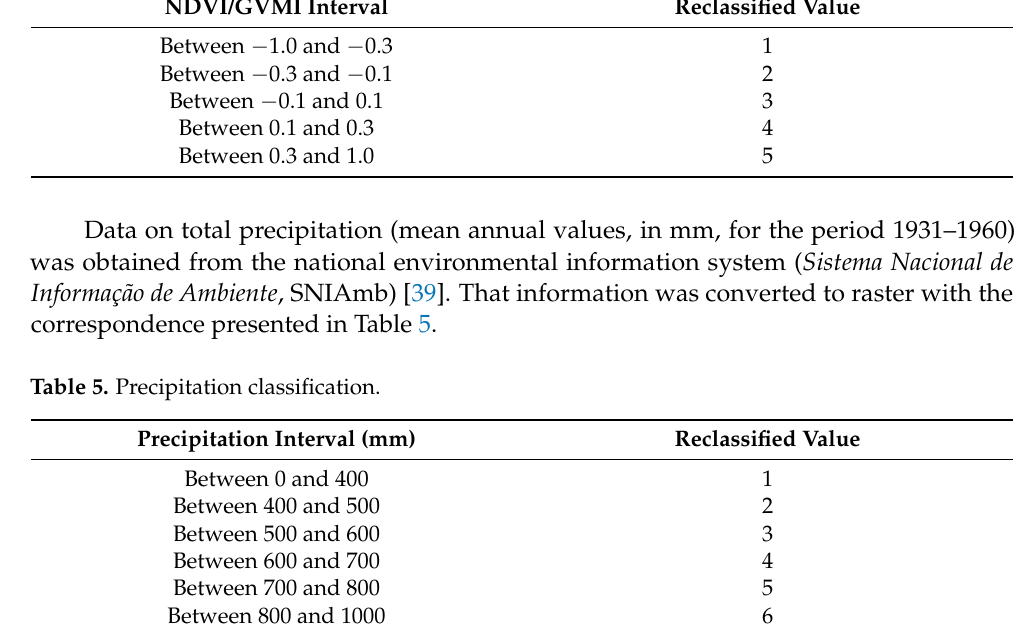
Table 4. NDVI and GVMI classification. NDVI/GVMI Interval Reclassified Value Between − 1.0 and − 0.3 1 Between − 0.3 and − 0.1 2 Between − 0.1 and 0.1 3 Between 0.1 and 0.3 4 Between 0.3 and 1.0 5